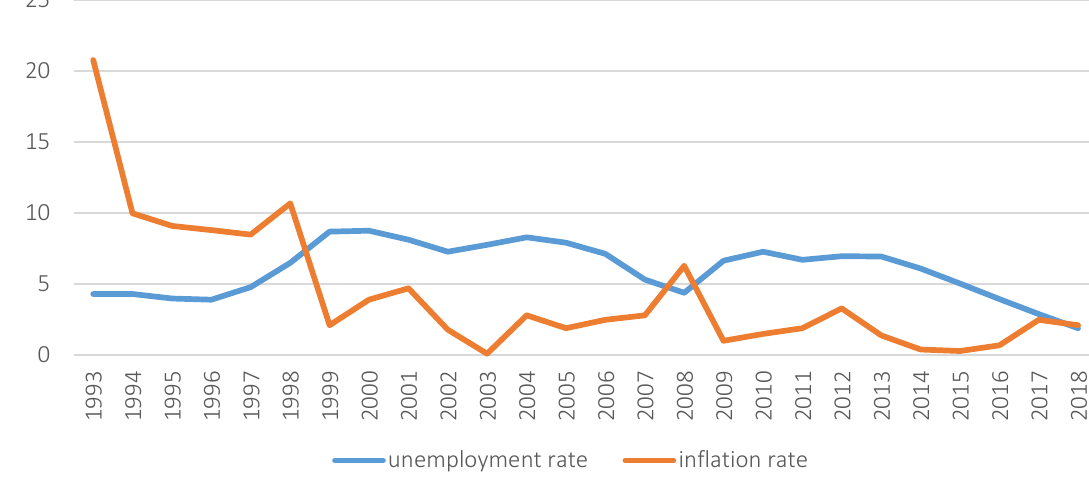
Figure 2. Development of the unemployment rate and inflation